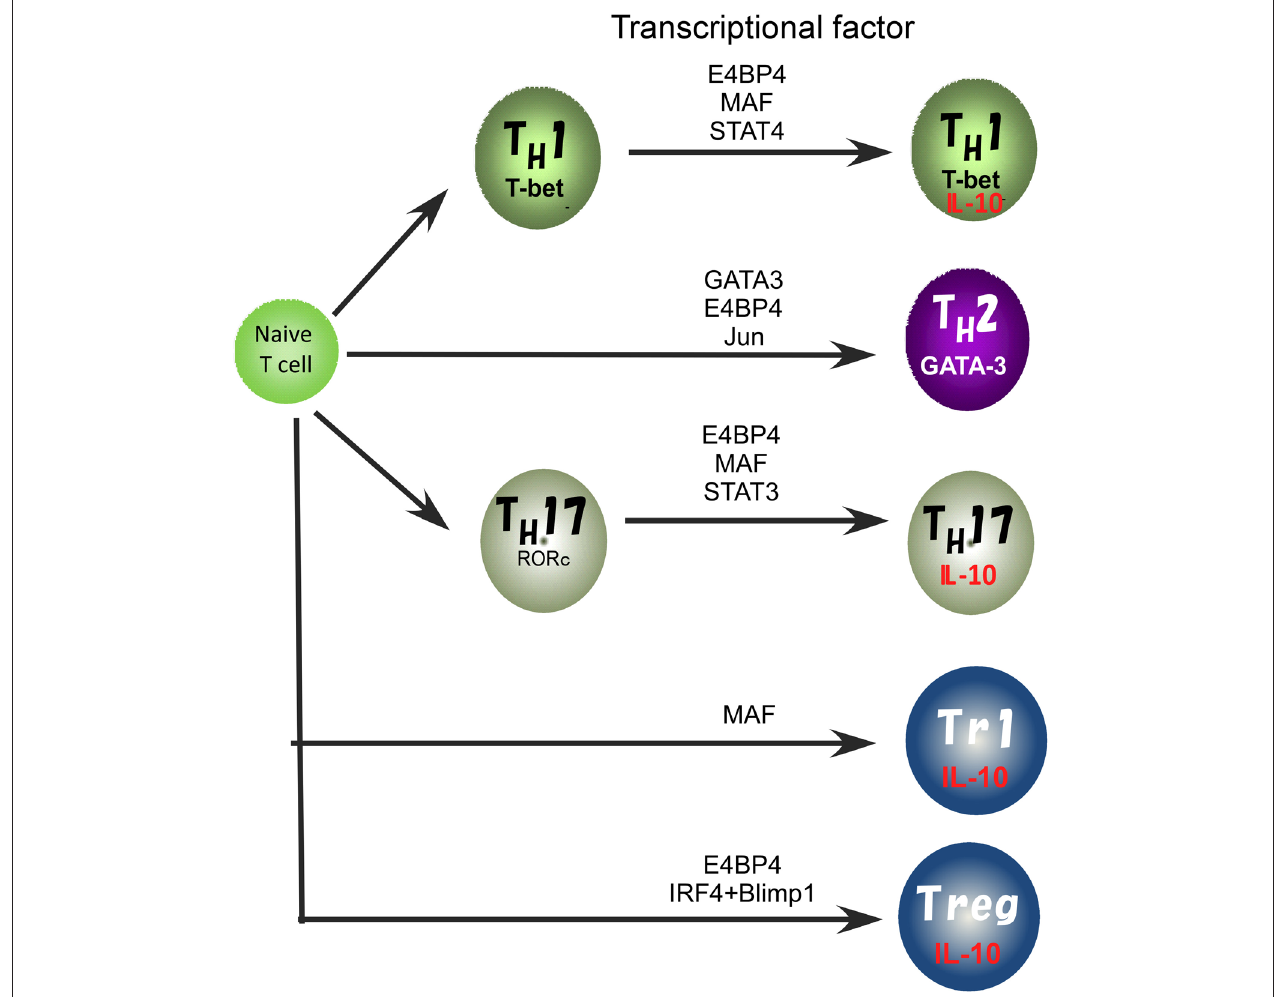
FIGURE 2 | Transcriptional factors regulating the IL10 gene expression in Treg, TH1, TH2, and TH17 cell